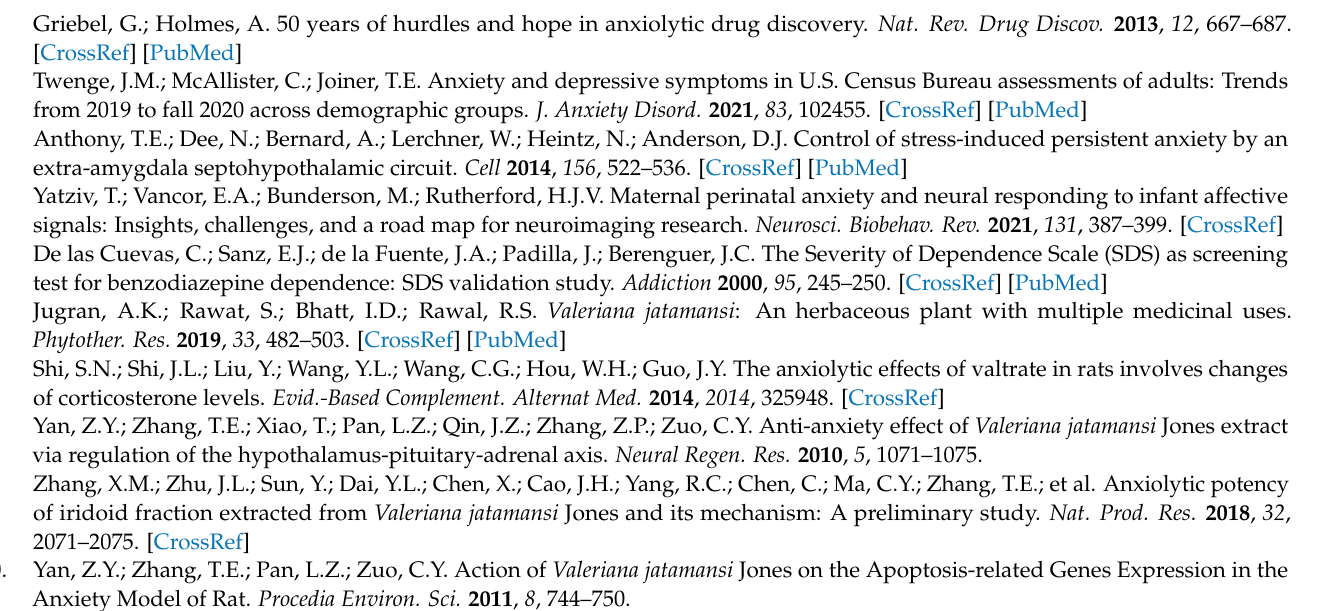
table of U*8(8 5 ); Table S3: Anxiolytic effect of ZZX-UDGs on EBS rats in the behavioral test; Table S4: Table S5: Name and classification of metabolites in rat hippocampus; Table S6: Effect of ZZX-ACG on the action targets of differential metabolites in the hippocampus of anxiety